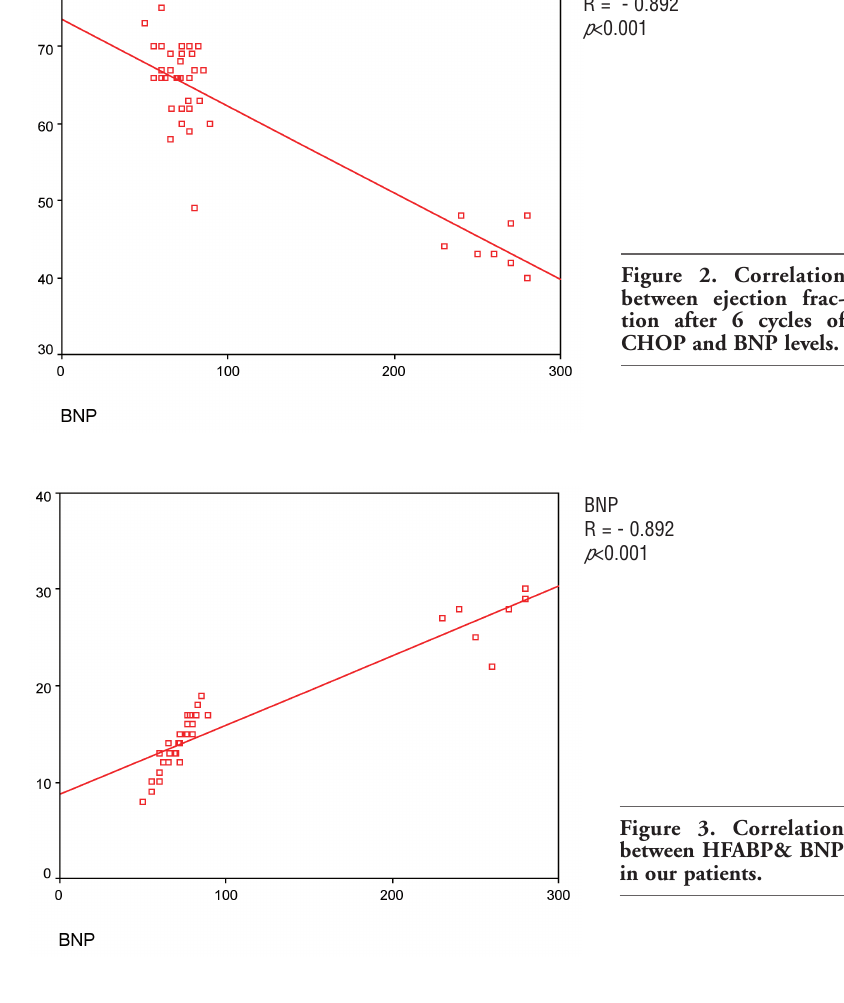
Figure 2. Correlation between ejection frac- tion after 6 cycles of CHOP and BNP